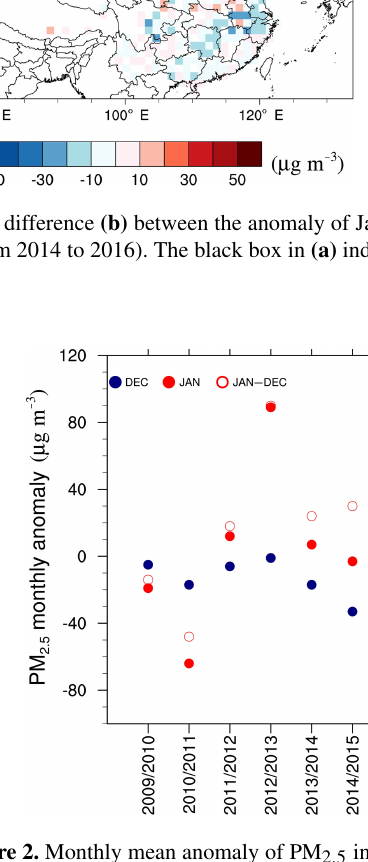
Figure 2. Monthly mean anomaly of PM 2 . 5 in the adjacent months of December (solid blue) and January (solid red) as well as the change (hollow red circle) from December to January during 2009– 2017 over the U.S. Embassy Beijing. For December (January), the anomaly is relative to the 2009–2016 (2010–2017) 8-year respective monthly mean